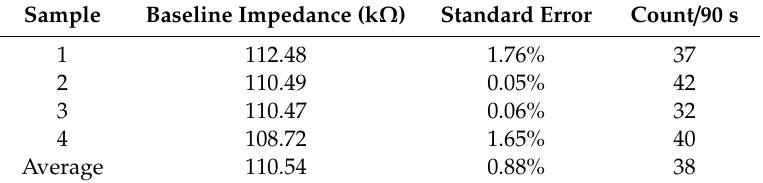
Table 2. Experimental results showing the average impedance of sperm.